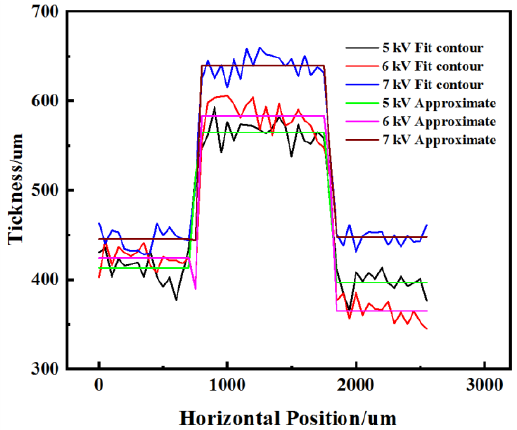
Figure 10. Local deformation profile for different discharge voltages at 1 mm initial gap. Table 7. Height of local deformation of the tube ( µ m) for different initial gaps and discharge voltages.